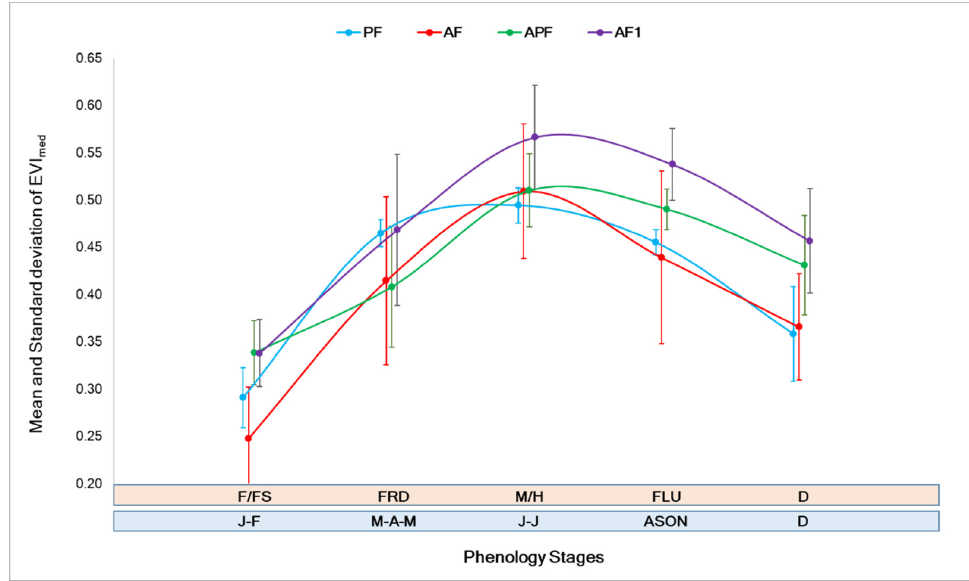
Figure 3. Overall mean and standard deviation of the four farms for the five phenology stages (F/FS, FRD, M/H, FLU and D) over the four years (2017–2020). X -axis offsets have been added to avoid overlapping error bars.